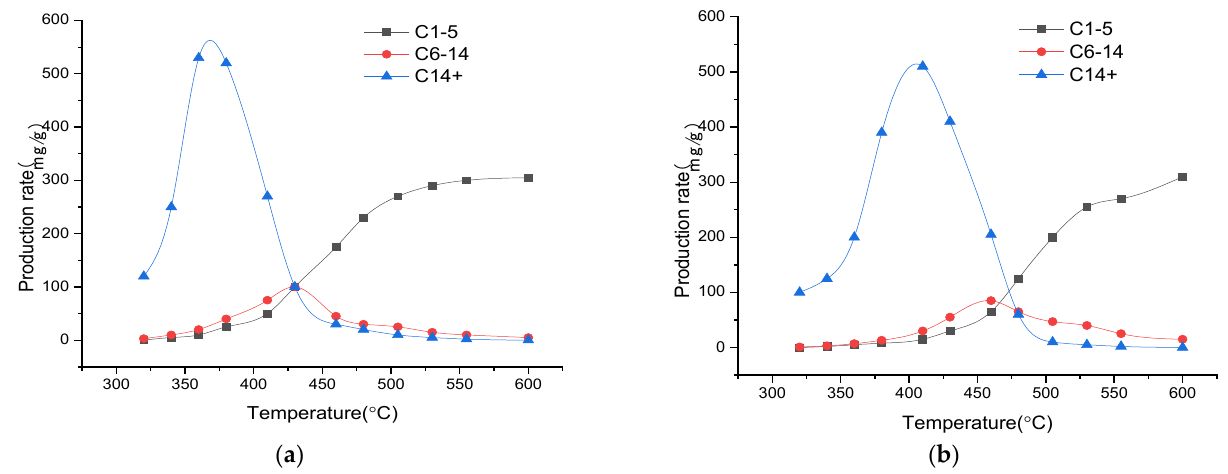
Figure 6. Yield curves for each component in the closed system; ( a ) 2 °C/min; ( b ) 20 °C/min. The yield curves of the three components show that the gas generation process lasts the longest, and the gas is generated from the beginning to the end of the experiment. The generation duration of light oil components is relatively short, and the yield reduced to a low level before the temperature of ~550 °C was reached. The time period during which heavy oil components are generated is the shortest, and hydrocarbon generation ends at 500 °C.